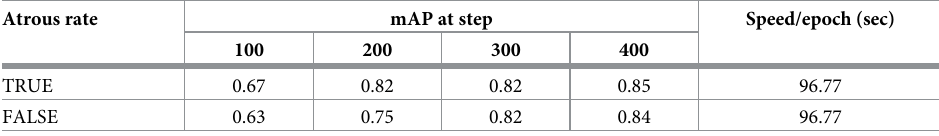
Comparison of the mAP values of the models trained in two scenarios: when using an atrous rate (TRUE) and not using one (FALSE). This performance was evaluated at 100, 200, 300, and 400 steps, and the training time per epoch is shown in seconds for each